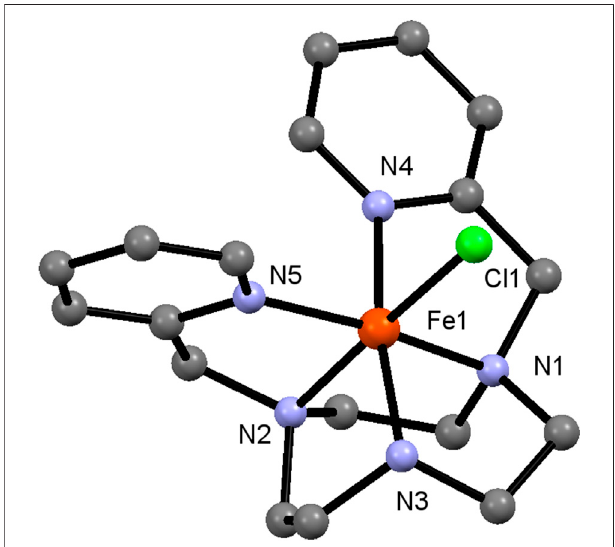
FIGURE 1 | Crystal Structure of Fe-L N3 . Hydrogen atoms and counter anions are omitted for